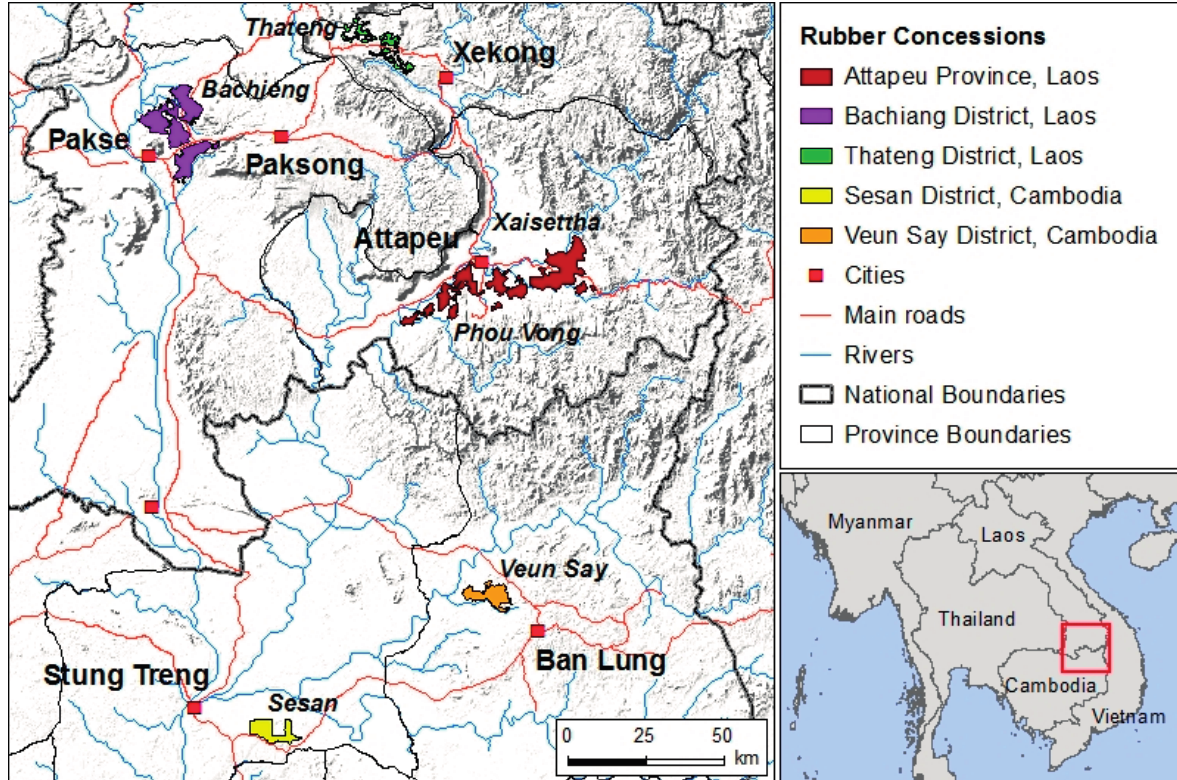
Figure 1. Rubber plantations in southern Laos and northeastern Cambodia investigated for this